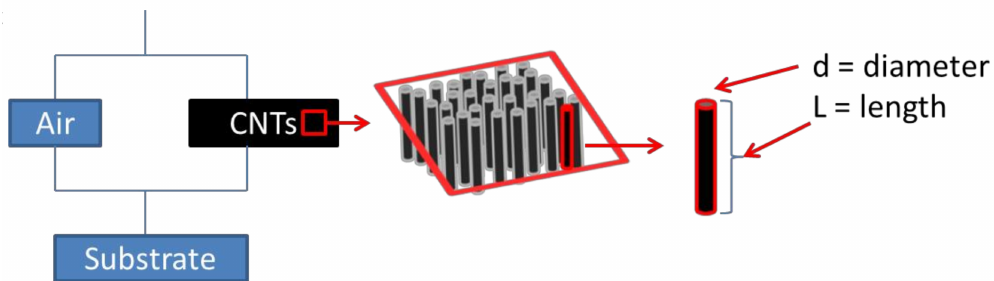
Figure 5. Modeling CNT array in parallel with air and image of simplified